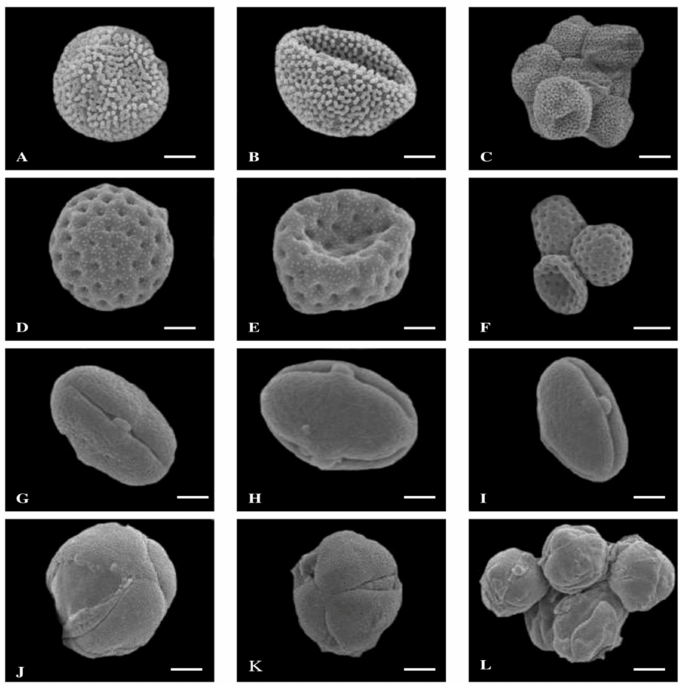
Figure 9. SEM images of pollen grains (Equatorial and Polar axis) and pollen surface ornamentation ( A – C ). The scale bar represents 10 µ m for Cissampelos parira ( D – F ), 5 µ m for Citharexylum spinosum